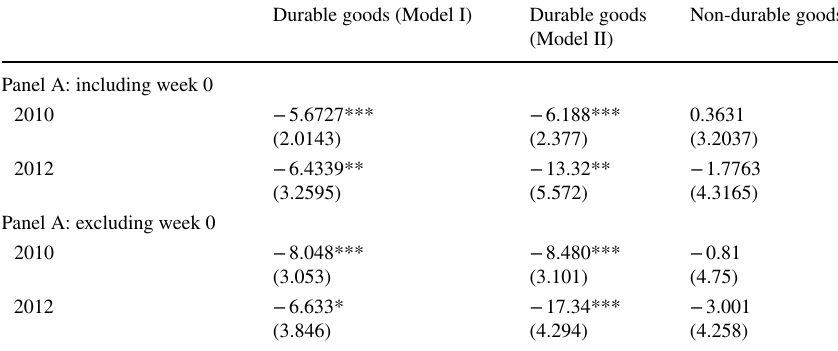
Table 3 Regression discontinuity (polynomial order 4): 2012 VAT reform impact on Google searches